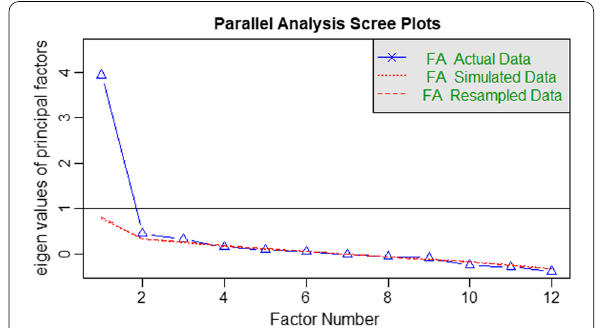
Fig. 1 Scree plot showing eigenvalues from parallel analysis of the